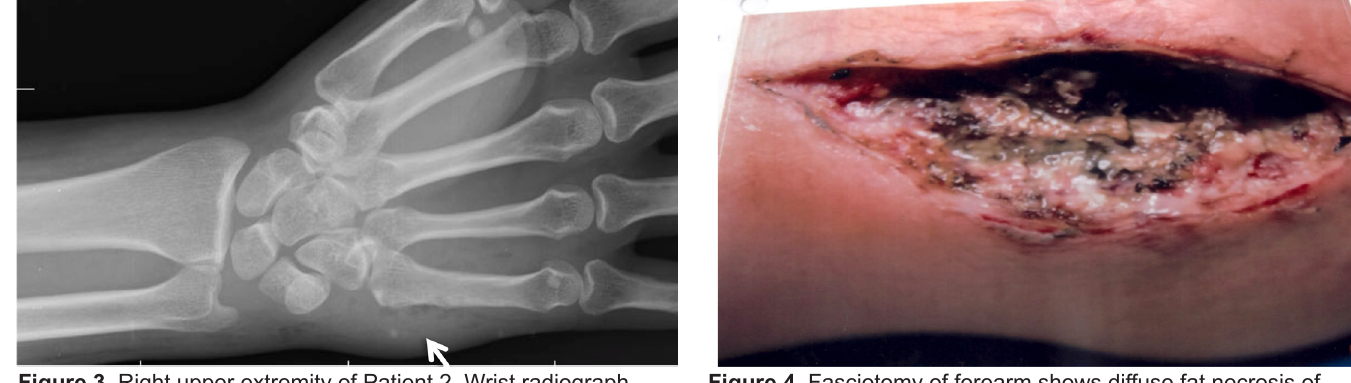
Figure 3. Right upper extremity of Patient 2. Wrist radiograph demonstrates subcutaneous emphysema (arrow) extending from injection site and hand down to forearm.